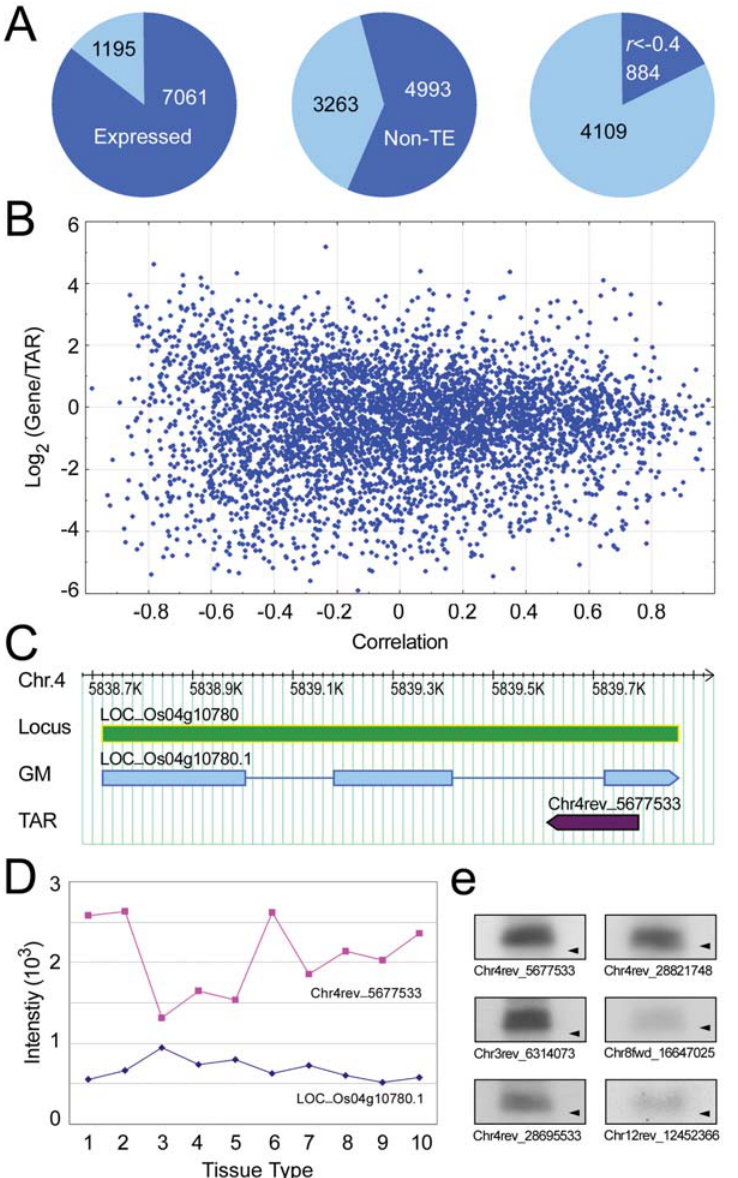
Figure 5. Characterization of antisense TARs. (A) Pie chart analysis of antisense TARs. Of the 8256 antisense TARs, 7061 were expressed in at least one tissue type according to the re-array (left), 4993 were antisense to a non-TE gene model (center), of which 884 had a transcriptional correlation coefficient with the corresponding gene models in the 10 assayed tissue types ,2 0.4 (right). (B) Scatterplot of the relative transcription level of the gene model/antisense TAR pairs in the cultured cell versus their correlation coefficient across the 10 assayed tissue types. (C) Annotation of an antisense TAR. The TAR Chr4rev_5677533 overlaps convergently with the gene model Os04g10780. (D) Transcription level of the TAR Chr4rev_5677533 and the gene model Os04g10780 in the 10 assayed tissue types. 1, cultured cell, 2, seedling root, 3, dark-grown seedling, 4, light- grown seedling, 5, leaf, 6, Xoo -infected leaf, 7, flag leaf, 8, whole flower, 9, carpel, and 10, developing seed. (E) Northern blot analysis of small RNA related to antisense TARs. The probes were PCR products derived from antisense TARs. The migration positions of a 21 nt RNA are indicated by the black triangle.